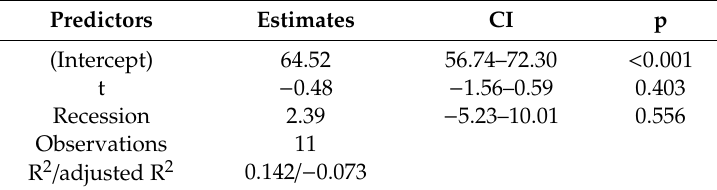
Table 5. Model 2 results for non-governmental non-profit sector.